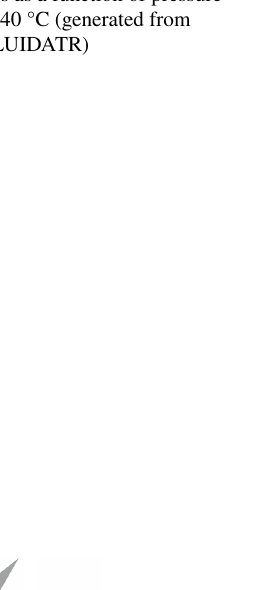
Fig. 2 CH 4 , N 2 and CO 2 densi- ties as a function of pressure at 40 °C (generated from